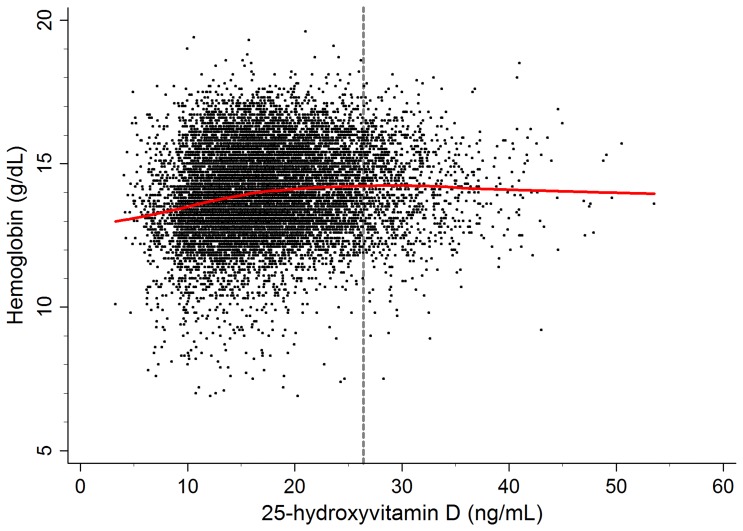
Scatter plot with the lowess regression curve between serum 25-hydroxyvitamin D and hemoglobin levels.